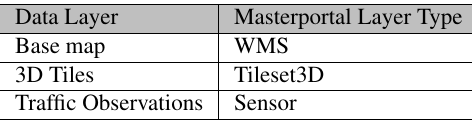
Table 2. Layer types used in Masterportal